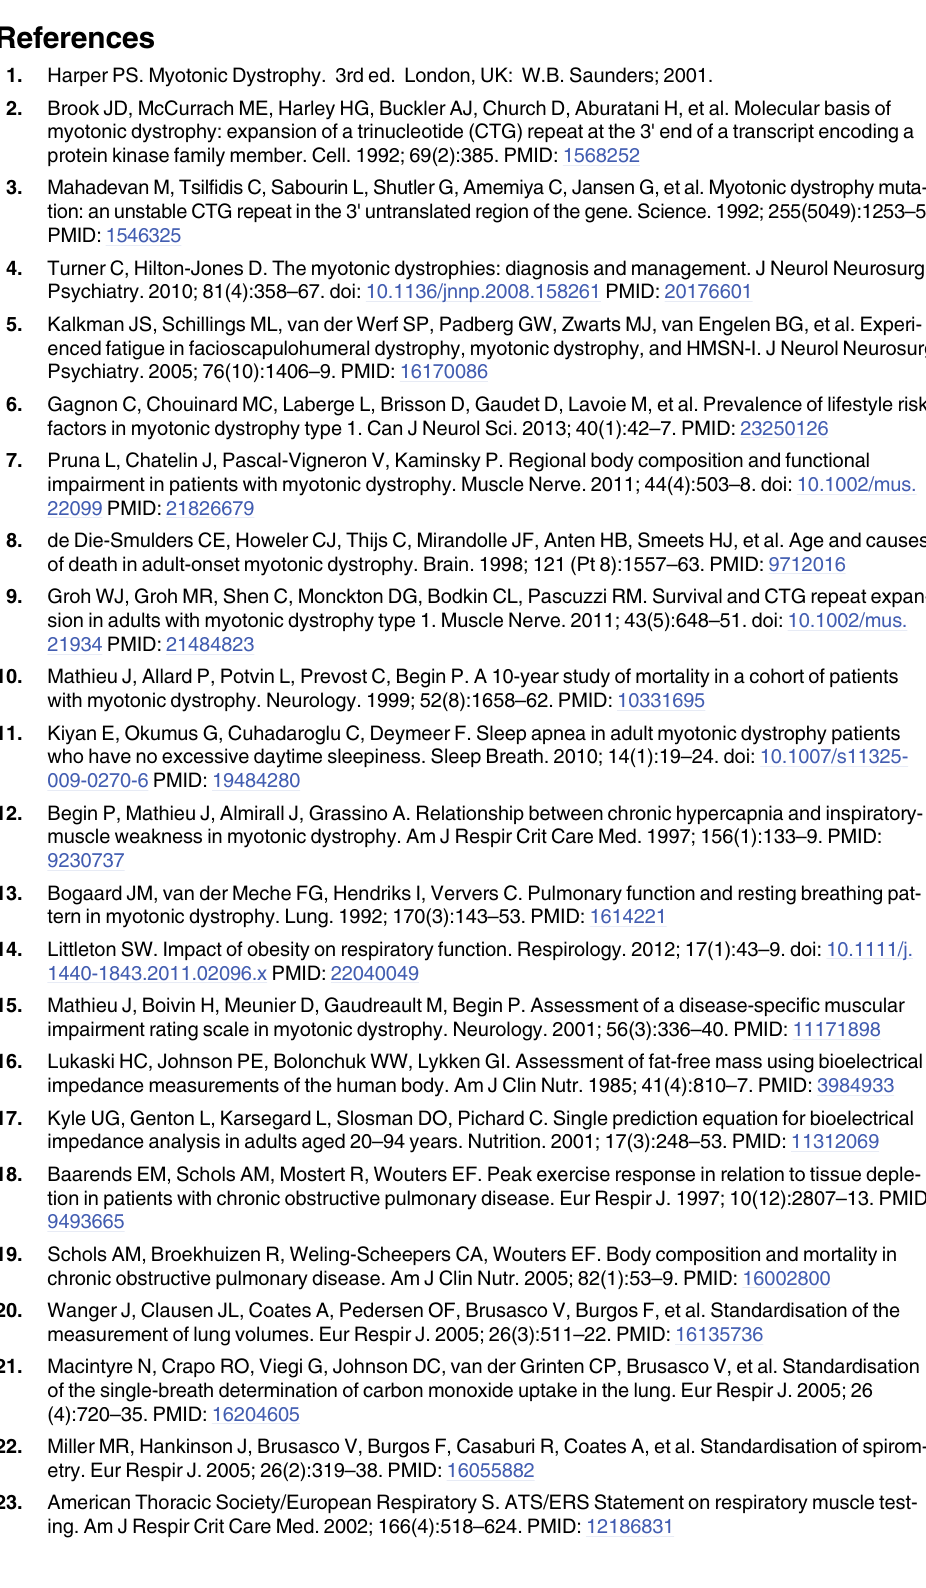
PLOS ONE | DOI:10.1371/journal.pone.0152344 March 25,